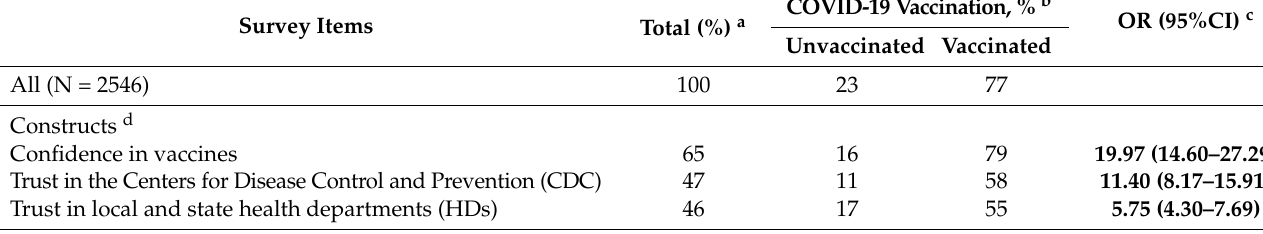
Table 2. Frequency and Odds of COVID-19 Vaccination by Vaccine Attitudes, Trust in CDC and HDs, and Sociodemographic Characteristics. Numbers in the “Total” column indicate the percentage of the total weighted sample providing the September 2021 survey response in each row. Numbers in the “COVID-19 Vaccination” columns indicate the percentage of those whose COVID-19 vaccination status match that of the column header who provided the survey response in each row. The numbers in the “OR (95%CI)” column indicate the Odds Ratio of being vaccinated vs. unvaccinated by the survey response in each row, boldface indicating statistical significance (p <